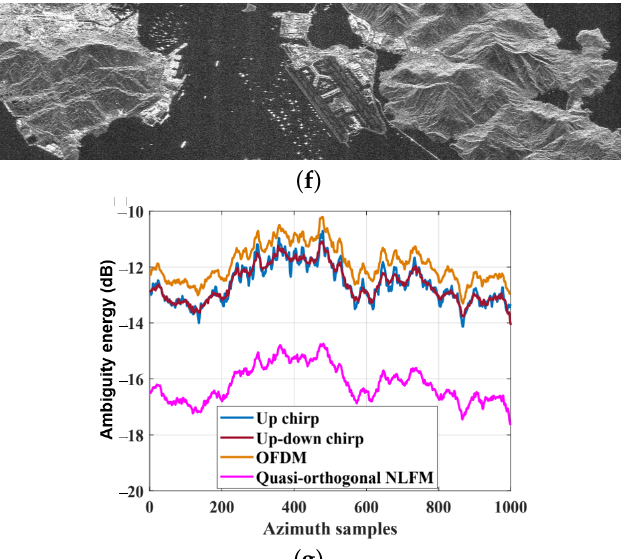
Figure 10. Range ambiguity suppression for the HV polarization of conventional quad-pol mode. ( a ) Image of the desired region. ( b ) Image of the range ambiguity region. Imaging results for ( c ) up chirp waveform, ( d ) up-down chirp waveforms, ( e ) OFDM chirp waveforms, ( f ) quasi-orthogonal NLFM waveforms. ( g ) Azimuth profiles of the ambiguity energy.